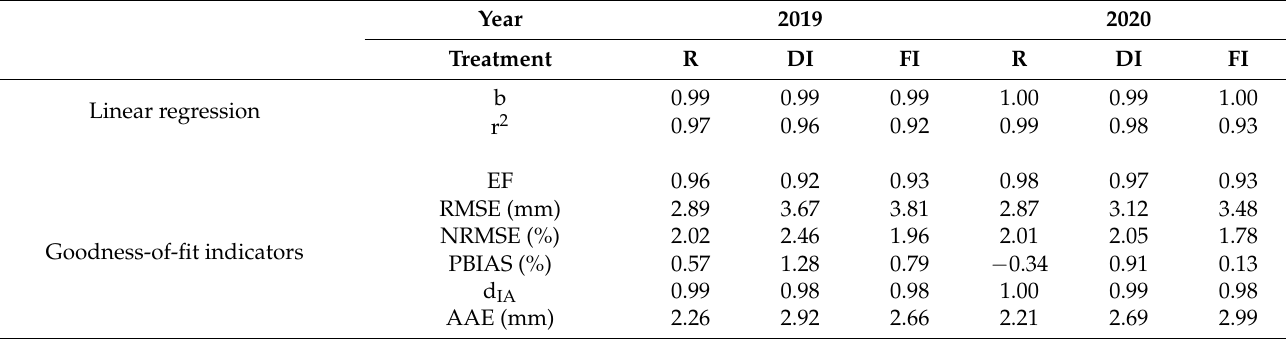
Table 5. Goodness-of-fit indicators relative to the SIMDualKc model calibration and validations for the different treatments in the 2019 and 2020 growing seasons.